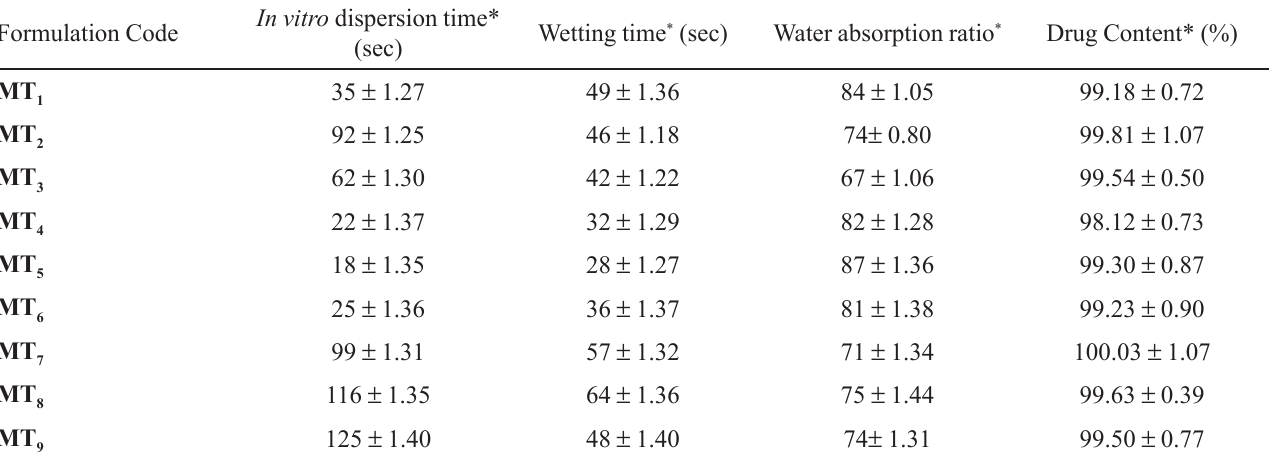
TABLE VI - Post-compressional parameters for direct compression method Formulation Code